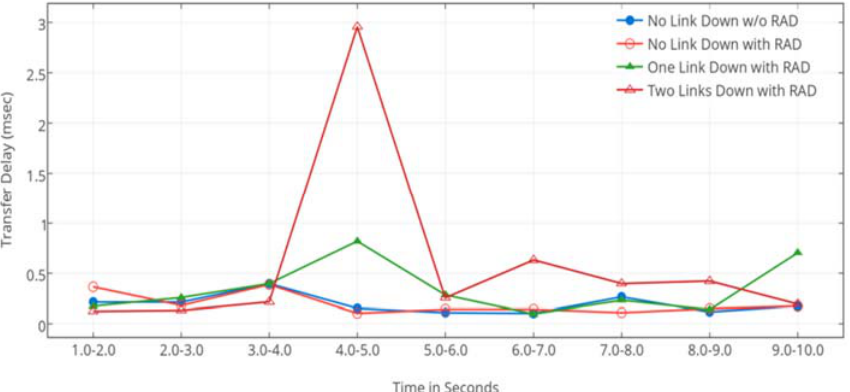
Figure 5. Transfer Delay (ms) vs. time.